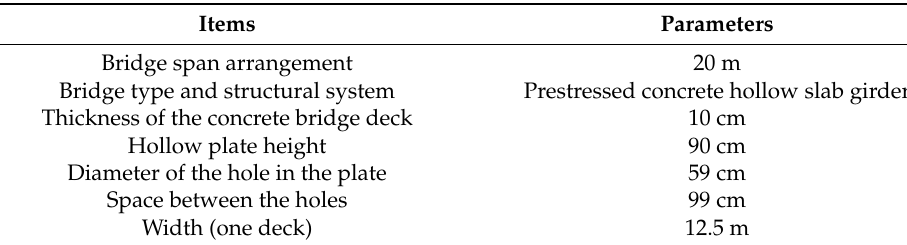
Table 2. Main size parameters of the hollow slab.